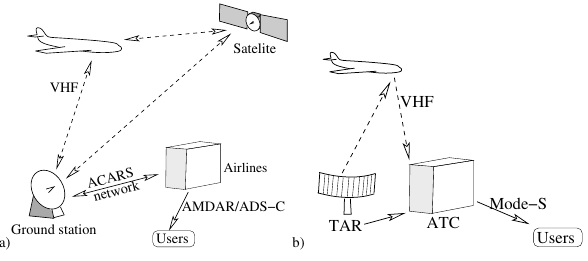
Fig. 1. Information flow for (a) ADS-C and AMDAR using ACARS Fig.1. Informationflowfora)ADS-CandAMDARusingACARSnetwork,andb)Mode-SEHSobservationsonlyavailableinthevicinity ofanMode-SEHStrackingradar. network, and (b) Mode-S EHS observations only available in the vicinity of an Mode-S EHS tracking equipped aircraft. This data block consists of aircraft identi- fication, position, time and flight level. Additional ADS data